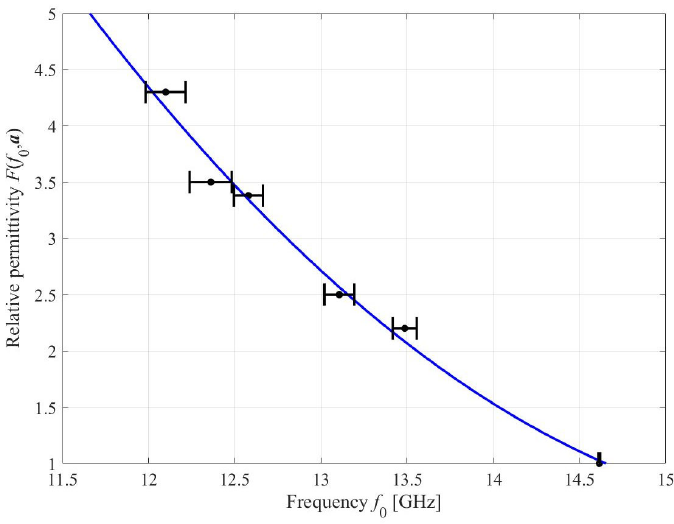
Figure 12. Calibration model of the proposed sensor. Circles correspond to the MUT measurement data in Table 3. Horizontal bars represent standard deviations of the measurement data.